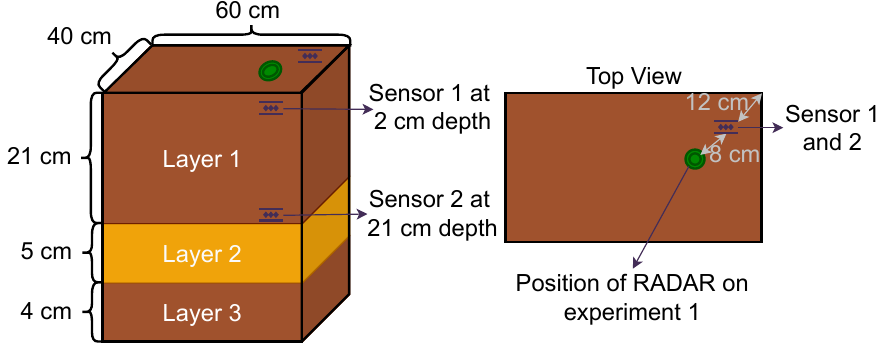
Figure 2. Disposition of the soil moisture sensors and soil layers in the big